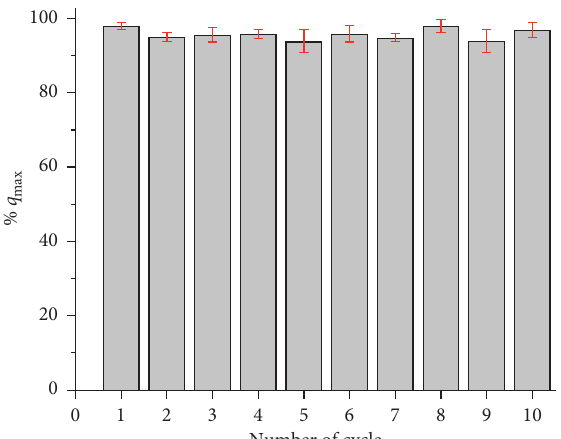
Figure 12: Recycling of the synthesized LEuH adsorbent in fluoride adsorption from aqueous solutions; 100% q temperature � 298K; mass of sorbent � 0.2 g. In cycle 1, we used LEuH-flocs, and in the subsequent cycles, we use LEuH-spinels obtained after calcination of LEuH-flocs at 500 ° C as sorbent materials.